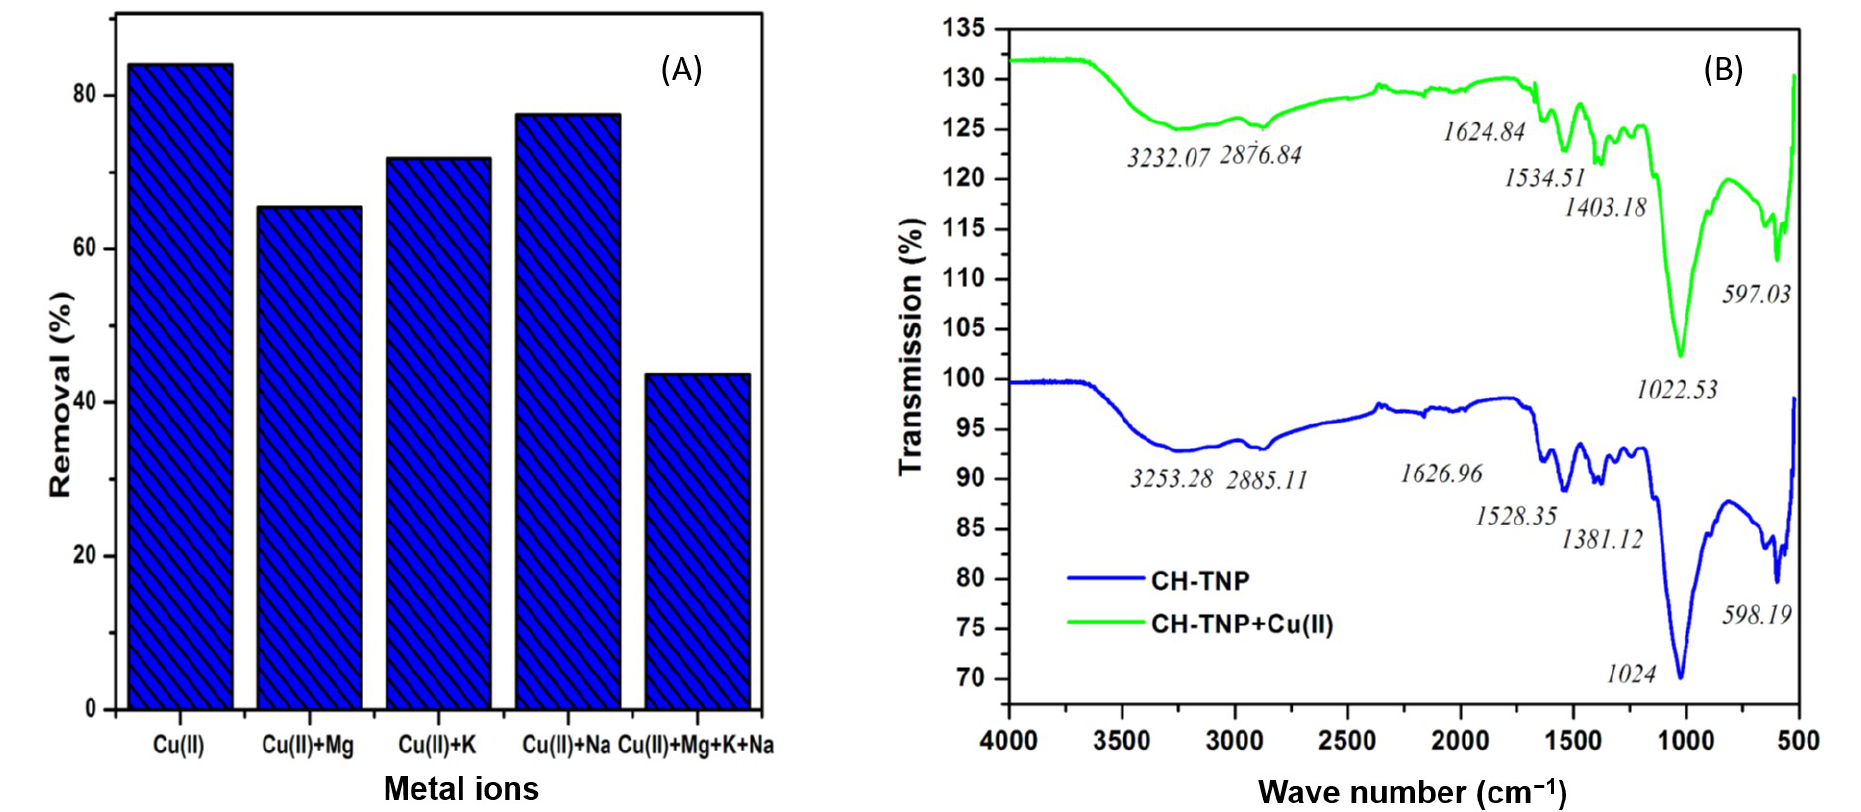
Figure 6. Effect of co-existing ions of Cu(II) adsorption ( A ), FT-IR spectra of pristine and Cu(II) saturated CH-TNP ( B ).